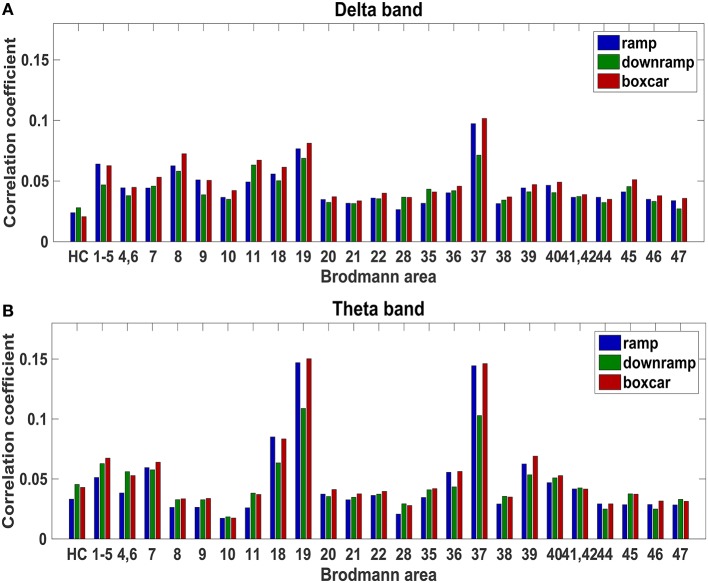
Correlation of regressors with 2–4 Hz delta (A) and 4–9 Hz theta (B) activity for each Brodmann area. HC, hippocampus; 1–5, Brodmann areas 1, 2, 3 & 5; 4,6, Brodmann areas 4 & 6. Ideally, neural accumulator candidates should have a higher correlation with the ramp regressor (blue) than with the downramp (green) and boxcar (red) regressors.